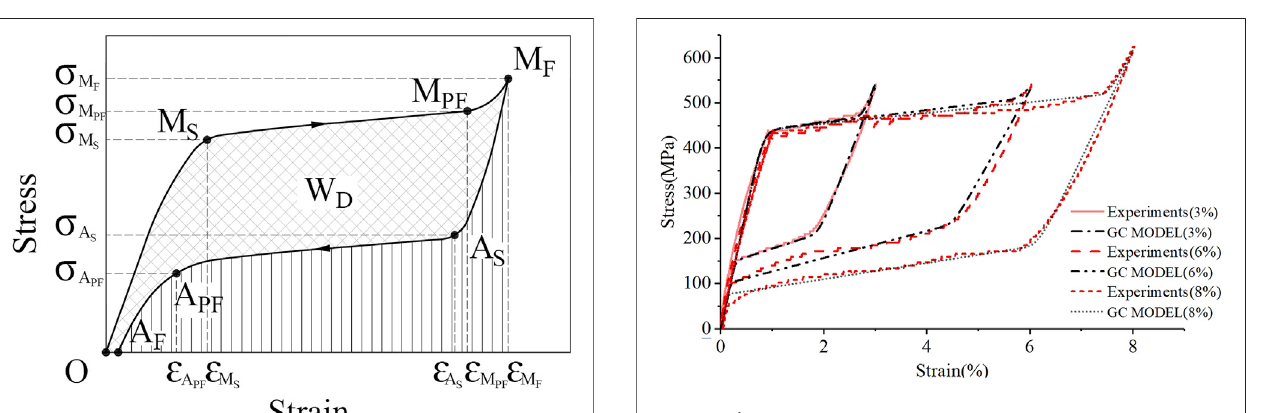
FIGURE 3 | Comparison between experiments and GC model with various strain